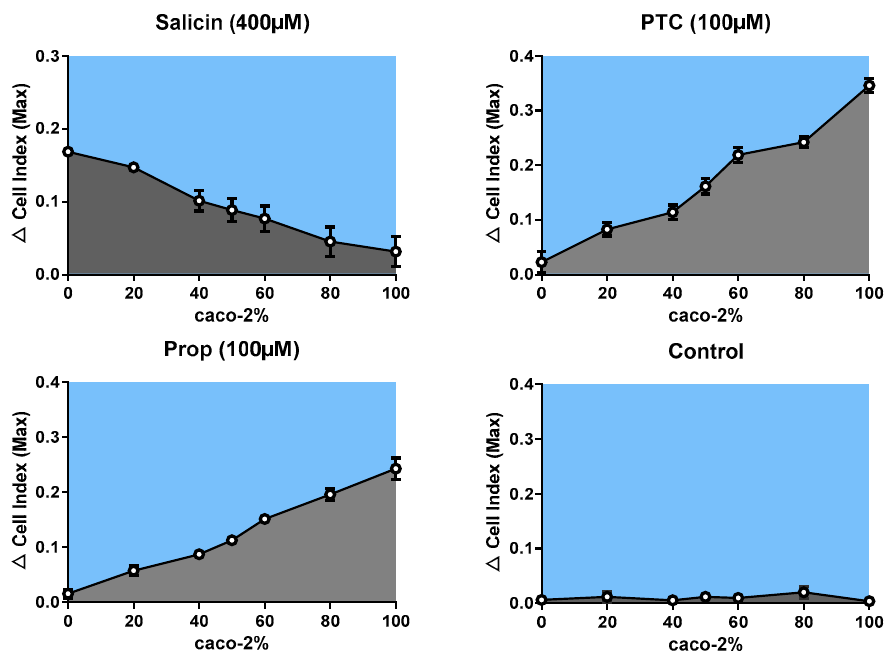
Figure 5. Visual analysis of cell co-culture taste sensor .